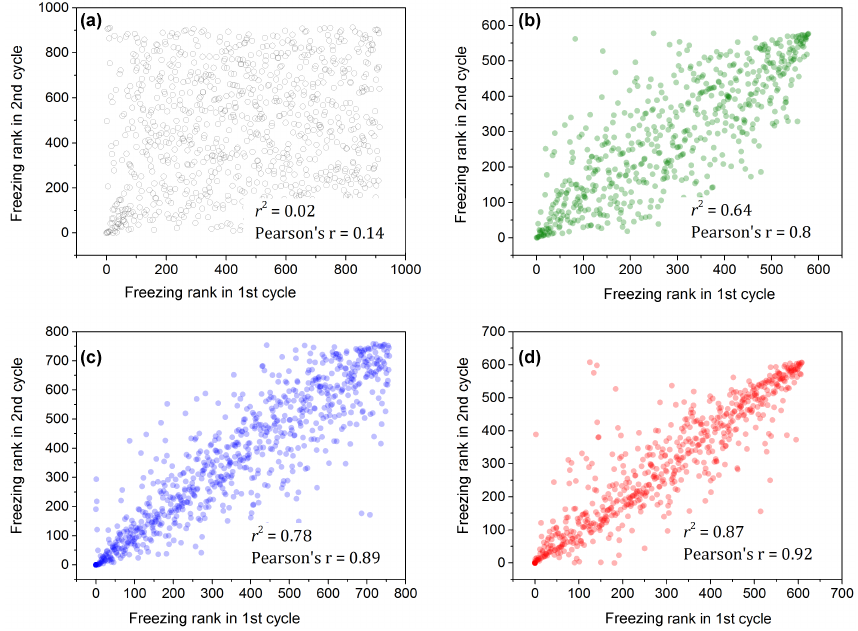
Figure 4. Correlations plots of freeze–thaw cycle experiments of feldspar suspensions (0.8wt%, 5Kmin − 1 ). (a) NanoPure water, (b) FS05, (c) FS01, and (d) FS04. In the bottom right corner of every panel the adj. r 2 and the Pearson’s r correlation coefficients describe the degree of